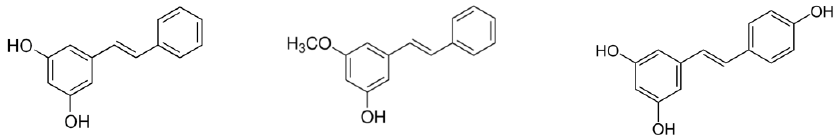
Figure 1. Chemical structures of pinosylvin, monomethyl pinosylvin and resveratrol.